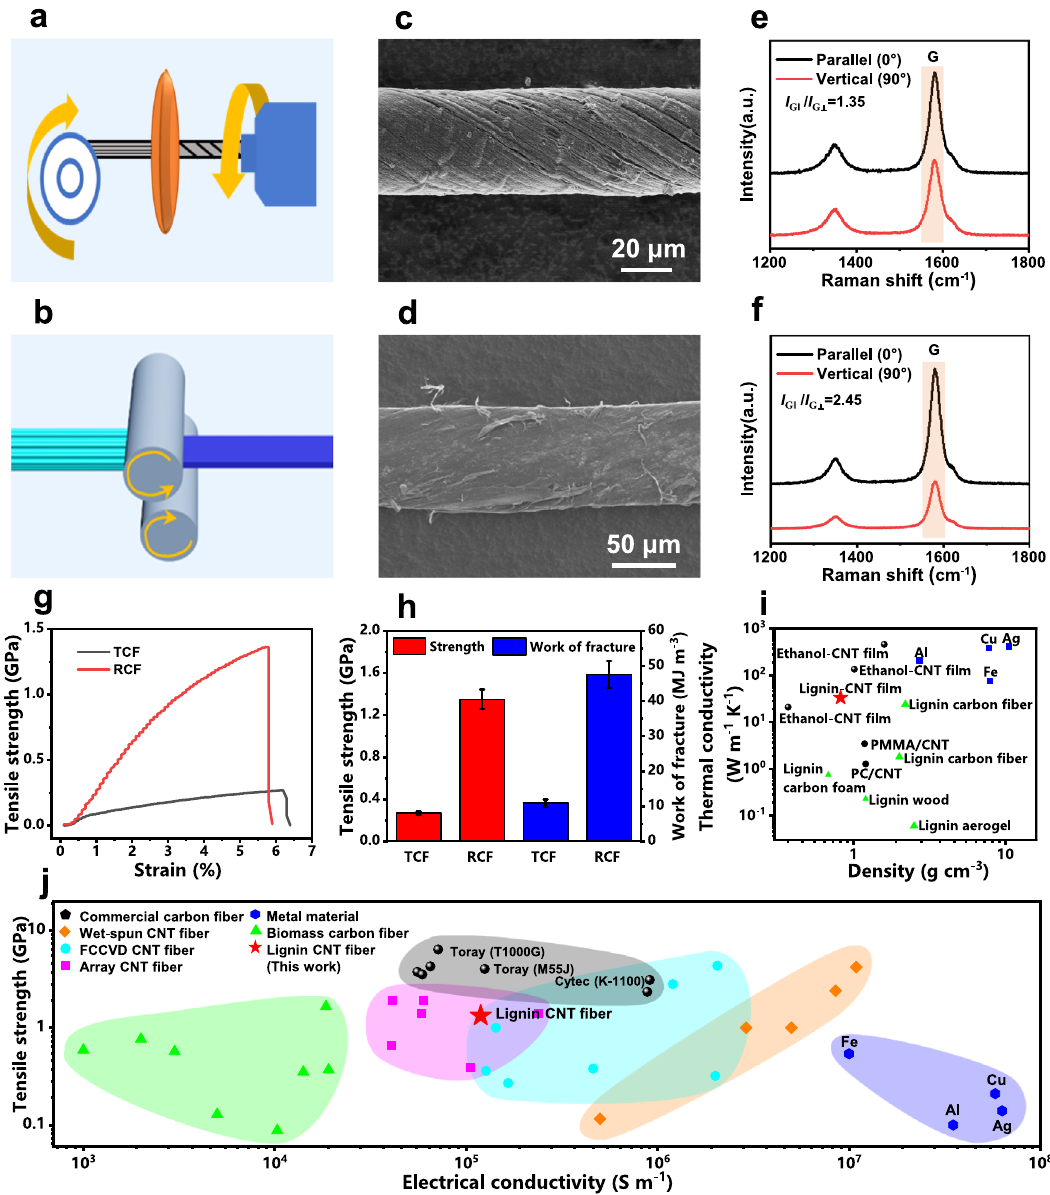
Fig. 4 | Preparation and properties of lignin-derived CNT fi bers. Preparation